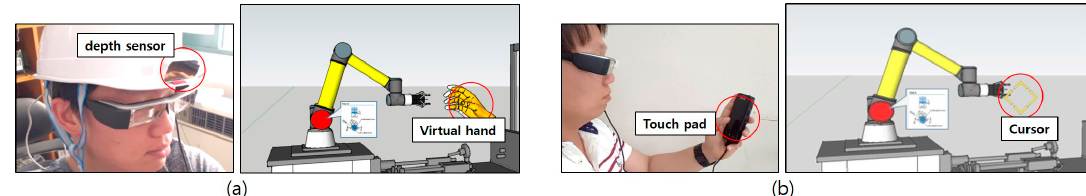
Figure 4. Two di ff erent types of AR interactions: ( a ) hand gesture; ( b ) touch Figure 4. Two different types of AR interactions: ( a ) hand gesture; ( b ) touch gesture.